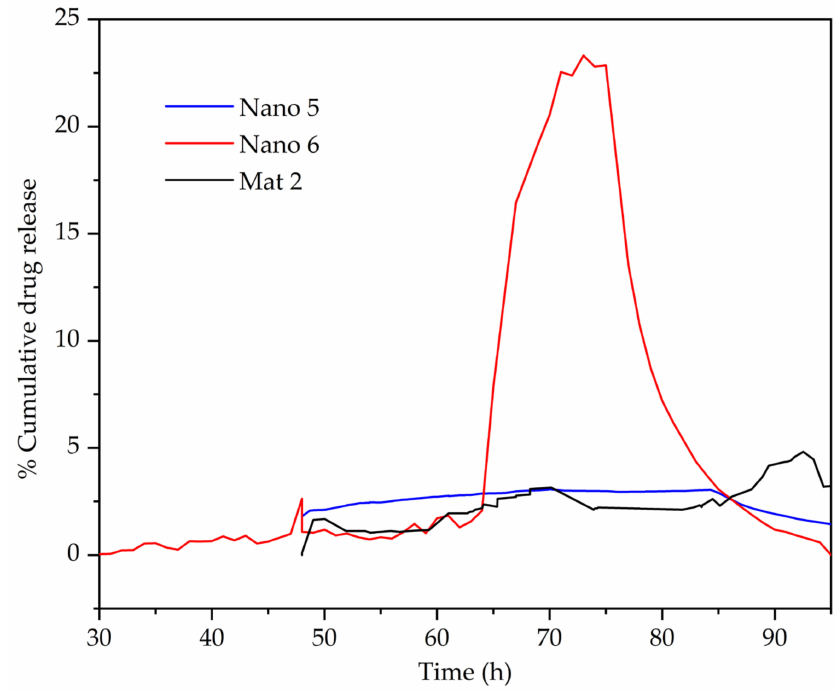
Figure 7. Hydrocortisone release profiles at pH 5 for Mat 2, Nano 5, and Nano